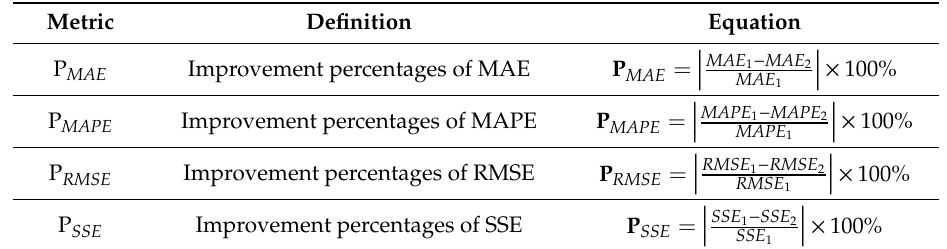
Table 10. Brief definition of four metrics.